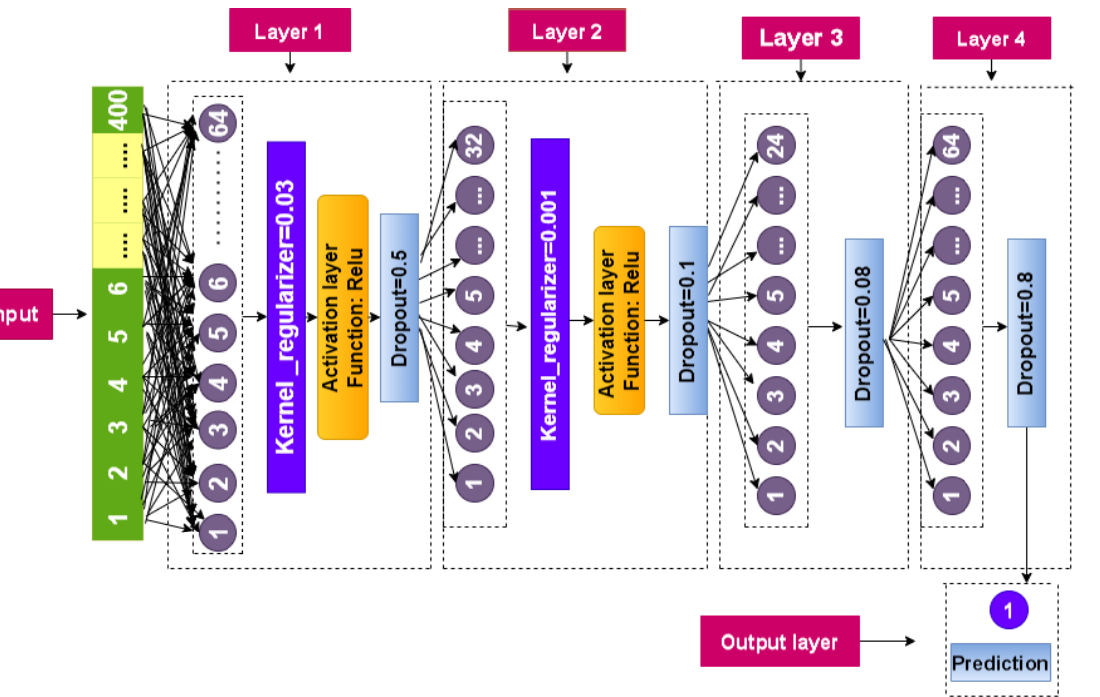
Figure 5. The architecture of optimized long short-term memory (OLSTM), a fine-tuned network.